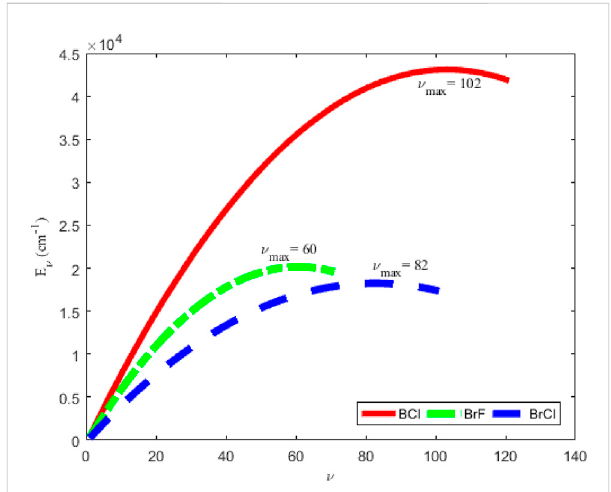
FIGURE 2 Variation of bound state energy eigenvalues versus vibrational quantum number for the ground state BCl, BrF, and BrCl